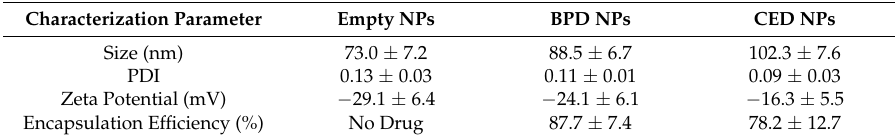
Table 1. Physicochemical Characterization of NPs ( n = 4).